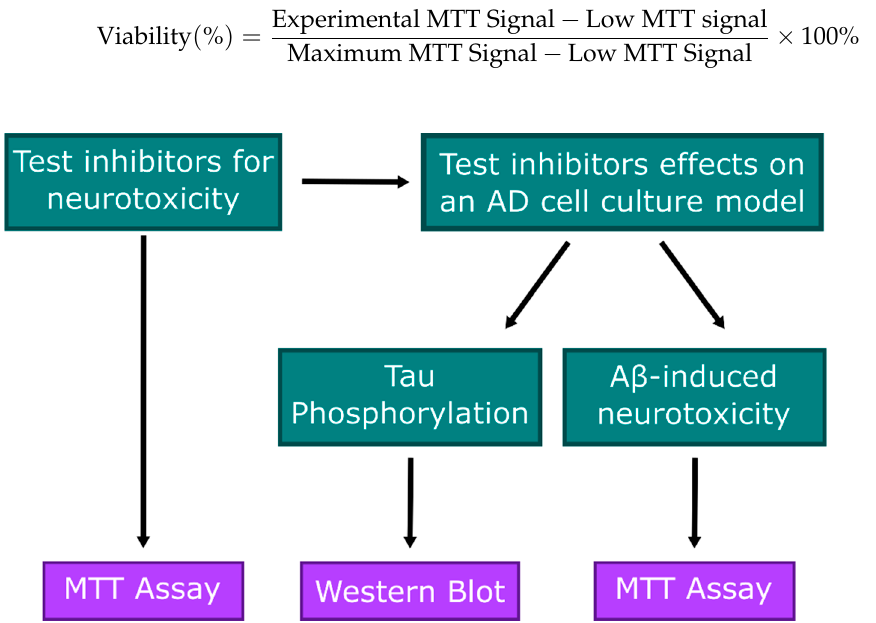
Figure 7. Experimental design. CaMK1D inhibitors were first tested for neurotoxicity by MTT assay. Following these results, the inhibitors were further tested for effects on tau phosphorylation and A β -induced neurotoxicity by western blot and MTT assay, respectively.